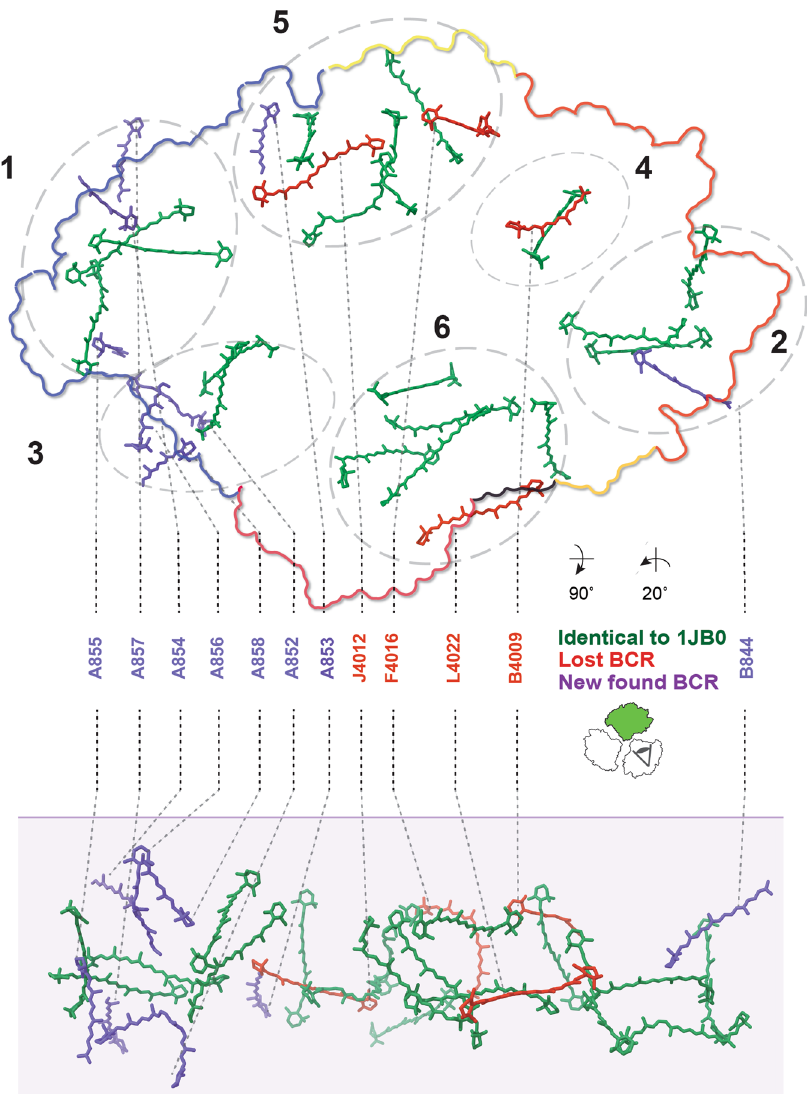
Fig. 6 Carotenoid network. View on the membrane normal from the stromal side (upper panel) with monomer outlined according to subunit color. Lower panel: side-view along the membrane plane with the membrane indicated in shade. Carotenoids found in both monomer and trimer structures are colored in green, carotenoids not found in the monomer structure are colored in red and newly found ones are colored in blue. Carotenoids are clustered according to Jordan et al. 8 and indicated by dashed circles and their respective